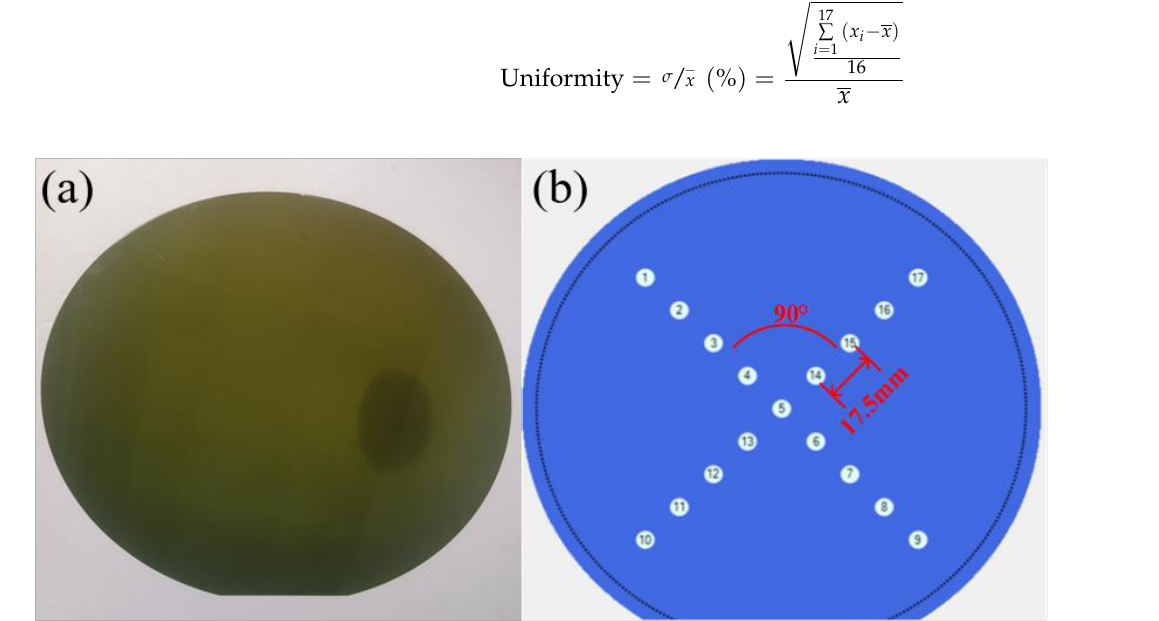
Figure 2. 150 mm 4H-SiC wafer: ( a ) wafer after epitaxial growth, ( b ) seventeen test points on the wafer surface.